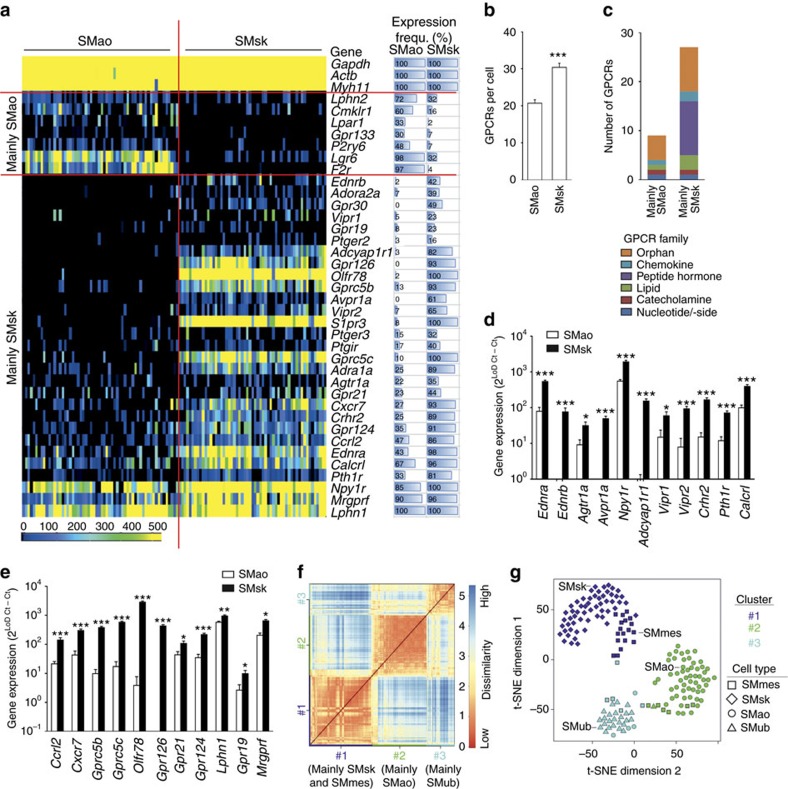
Single-cell GPCR expression in different SMC types.(a) Heat map of GPCR expression in SMao and SMsk (60 and 57 cells per SMC type, from seven to eight mice each); horizontal bars on the right side visualize expression frequency (in %) (for full data sets, Supplementary Fig. 6). (b) Average number of GPCRs expressed in individual SMao and SMsk. (c) GPCRs preferentially expressed in SMao or SMsk grouped by GPCR family. (d,e) Comparative analysis of expression strength for different peptide hormone receptors (d) or members of the chemokine/orphan family (e) in SMao and SMsk. (f,g) K-means clustering results for different SMC types: (f) Heat map indicating degree of similarity between individual cells as measured by Euclidian distances of the transcriptome correlation matrix. K-means clustering identified three major groups of cells which are colour-coded along the axes. (g) t-SNE map representation of clusters identified in f: the more similar two cells are, the closer together they are plotted (each dot one cell). Cluster assignment is indicated by colour, cell type is indicated by symbols. SMmes, SMC from mesenteric vasculature (29 cells from eight mice); SMub, SMC from urinary bladder (25 cells from eight mice). Expression data are calculated as 2(Limit of detection(LoD) Ct—sample Ct); LoD Ct was set to 24. Data in b,d,e are shown as mean±s.e.m.; comparisons between groups were performed using two-tailed t-test. *P<0.05; **P<0.01; ***P<0.001.